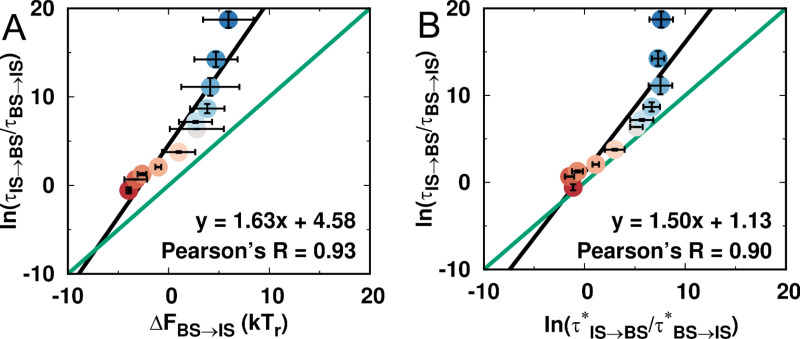
Comparison of thermodynamic and kinetic stabilities of the IS and BS during DPO4–DNA binding for different values of ρ.A direct comparison between the thermodynamic and kinetic results can be made by comparing the thermodynamic and kinetic stabilities as suggested previously (Wang et al., 2017). The thermodynamic stability is defined as Δ⁢FBS→IS=FBS-FIS, where F is the free energy obtained from the free energy landscape, while the kinetic stability is defined as k⁢Tr⁢ln⁡(τIS→BS/τBS→IS), where τtrans is the transition time calculated from the kinetic simulations. (A) Correlation between thermodynamic and kinetic stability. (B) Correlation between the kinetic stabilities of the IS and BS. τtrans* was calculated from the free energy landscape (see Appendix 1) and thus is the result from the thermodynamic simulation.